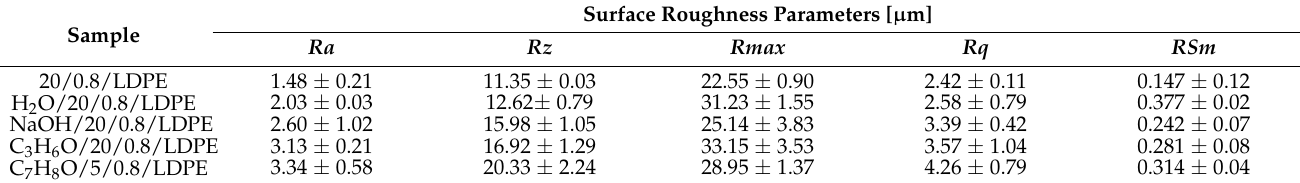
Table 2. Surface roughness parameters of 20/0.8/LDPE samples before and after the solvent immersion.